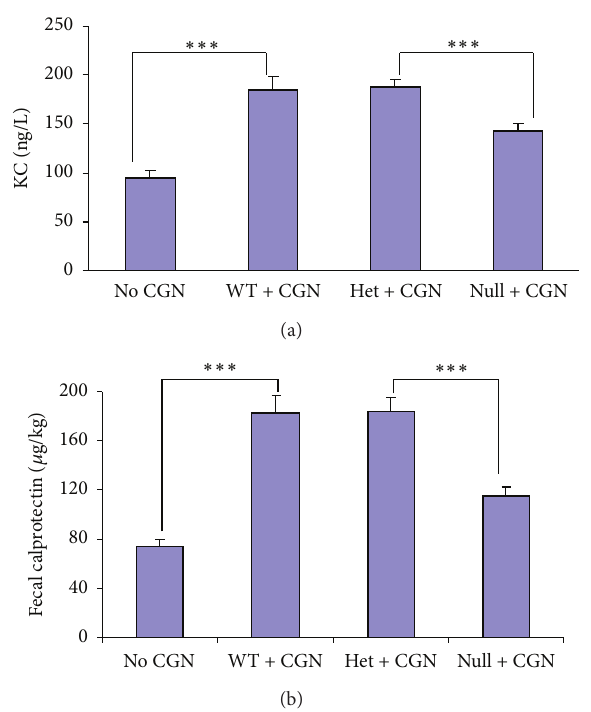
Figure 2: Carrageenan-induced increases in KC and calprotectin are less in Bcl10 null mice. (a) KC, the mouse homolog of IL-8, increased less in the Bcl10 null mice ( 𝑛 = 8 ) than in the wild type ( 𝑛 = 6 ) orheterozygous ( 𝑛 = 3 ) mice following carrageenan to ∼ 77% of the higher value ( 142.2 ± 9.0 ng/L versus 188.5 ± 6.4 ng/L; 𝑃 < 0.001 ). (b) Fecal calprotectin, an indicator of colonic inflammation, also increased less following carrageenan in the Bcl10 null mice than in the wild type or heterozygous mice, to 115.1 ± 8.0𝜇 g/kg versus 182.7 ± 14.3 𝜇 g/kg in the wild type mice ( 𝑃 < 0.001 ). CGN: carrageenan; KC: keratinocyte chemokine; WT: wild type; het: heterozygous.